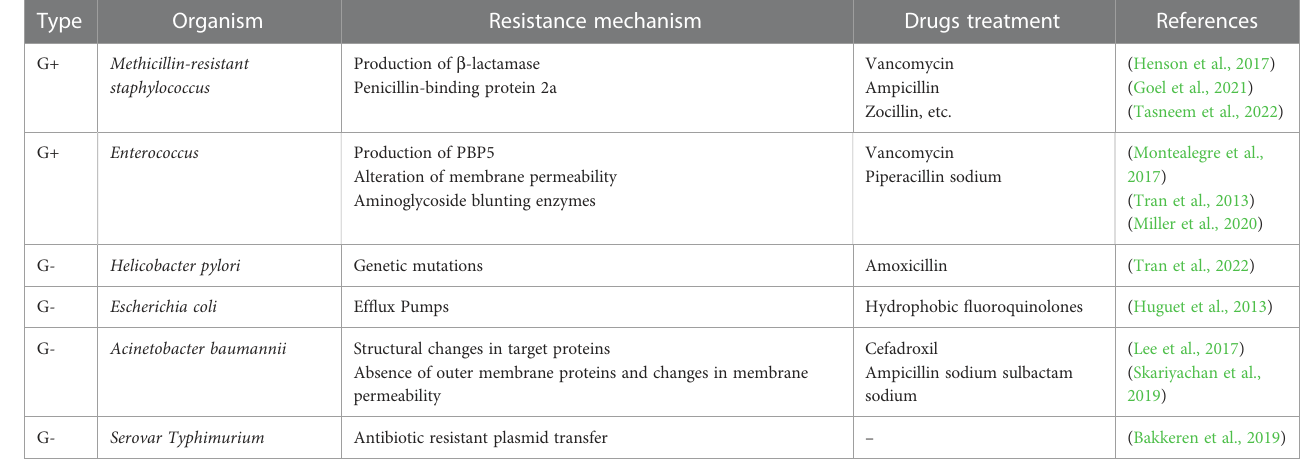
TABLE 1 Common drug-resistant bacteria and its